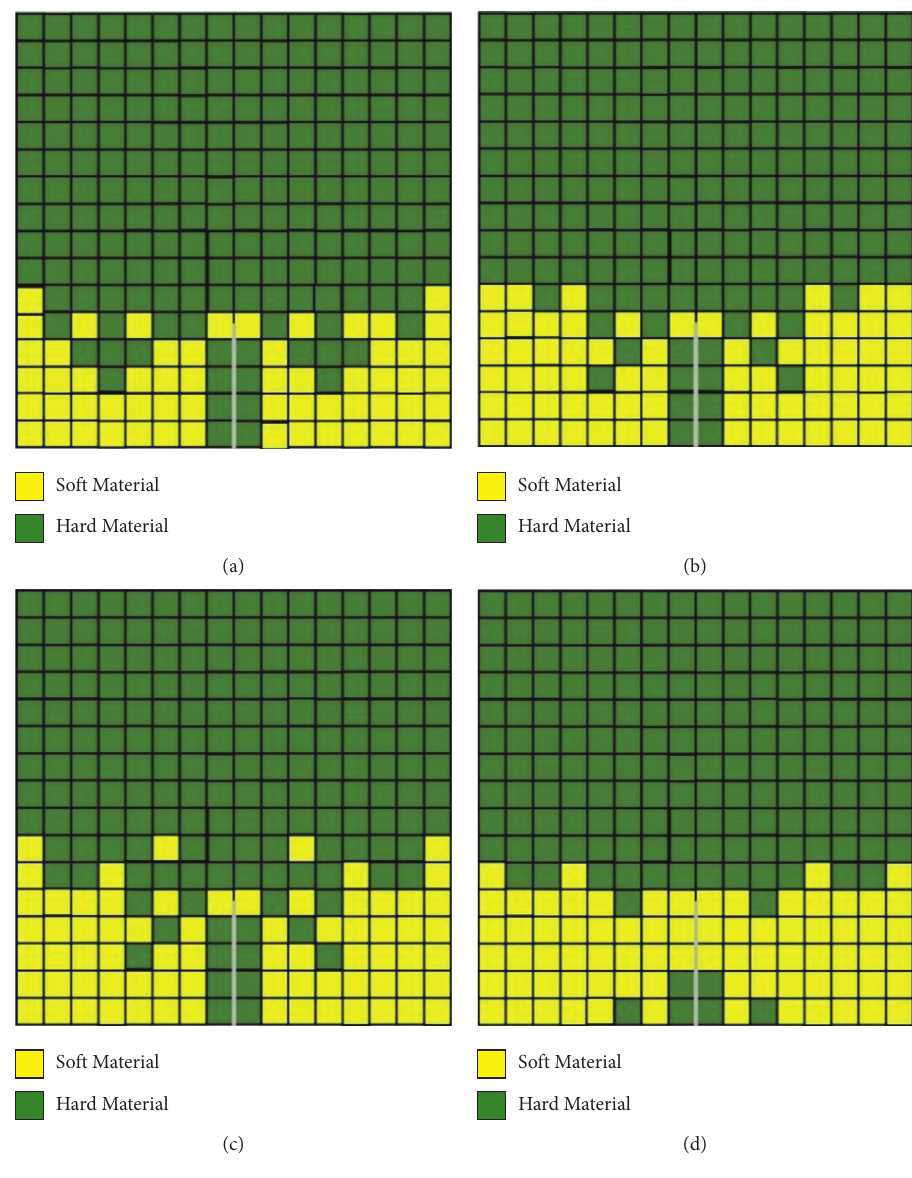
Figure 15: Optimization of multiobjective using GA method.